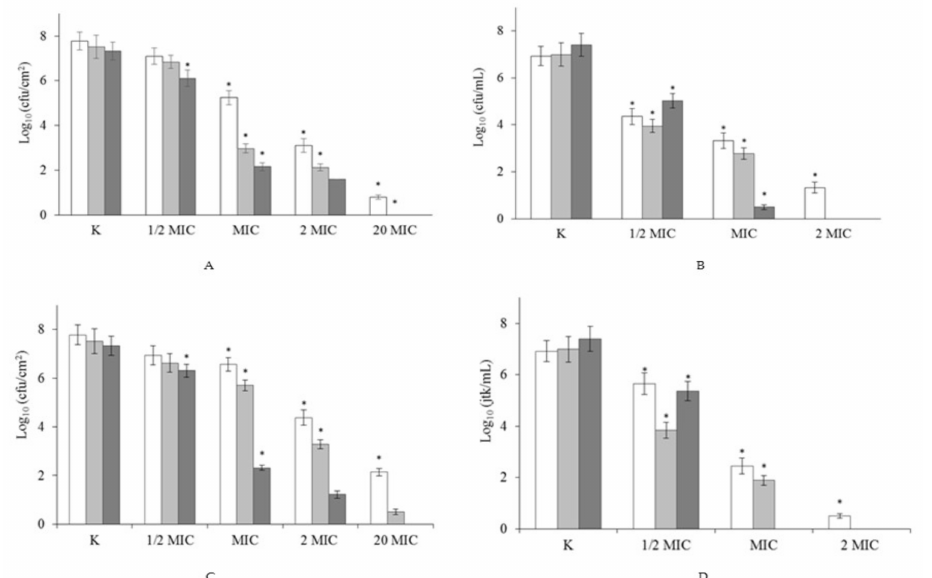
Figure 2. Effect of gemini C6 ( A , B ) and monomeric DTAB ( C , D ) surfactants on eradication of biofilm formed by P. aeruginosa ( A , C ) and planktonic cells ( B , D ). The results are presented after 1 h (white bar), 4 h (light grey bar) and 24 h (dark grey bar) treatment by biocides in the concentration 1 ⁄ 2 MIC, MIC, 2 MIC and 20 MIC, and compared to the control sample (K) without surfactants. * Reduced value of log 10 differed significantly from the control without surfactant